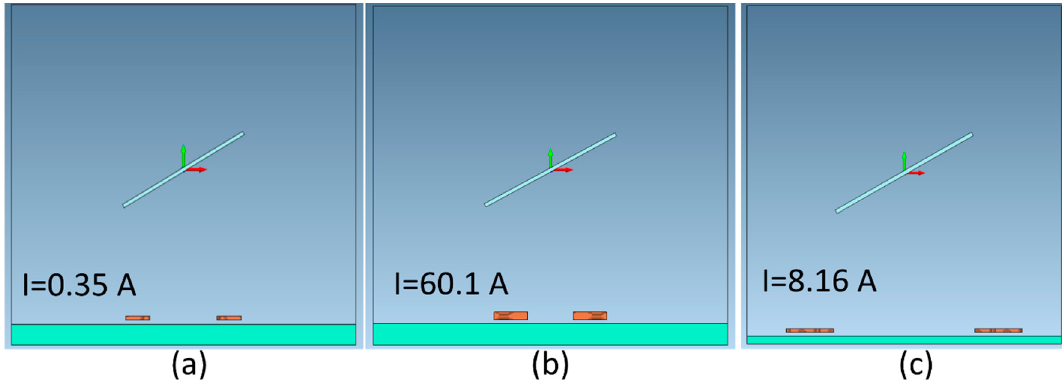
Figure 13. Geometry of solutions F PL ( a ), F AT ( b ), F SV ( c ).